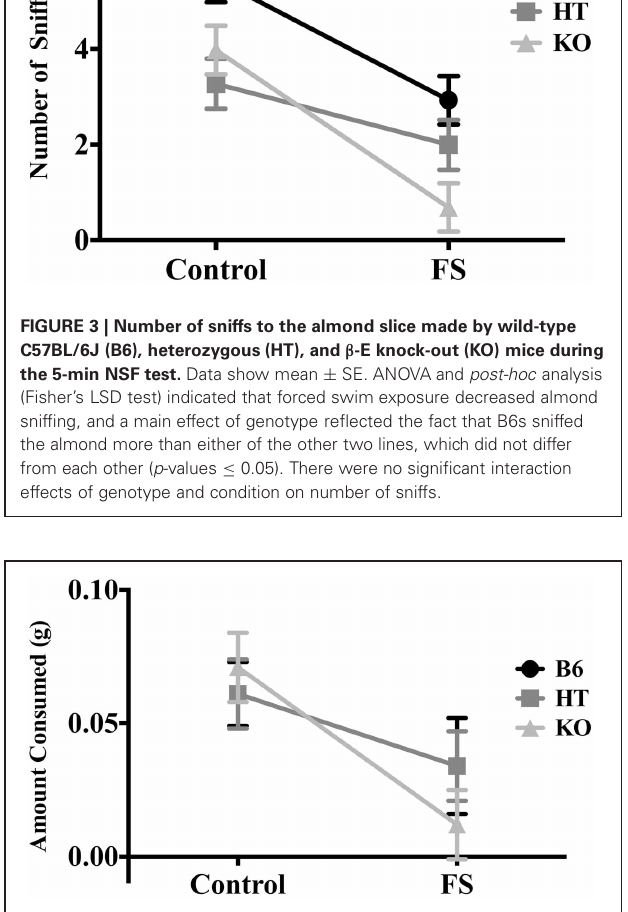
FIGURE 4 | Average amount of almond eaten during the 5-min NSF test by wild-type C57BL/6J (B6), heterozygous (HT), and β -E knock-out (KO) mice. Data show mean ± SE. ANOVA indicated that prior forced swim decreased consumption ( p ≤ 0.05), but there were no differences between genotypes, nor was this effect dependent upon